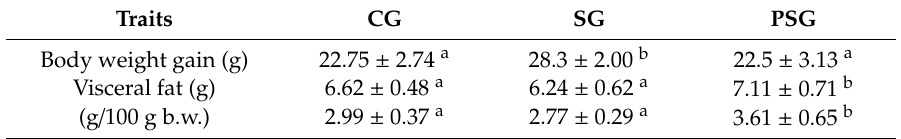
Table 4. E ff ect of frequent changes in diet or periodic starvation on rat body weight gain and visceral